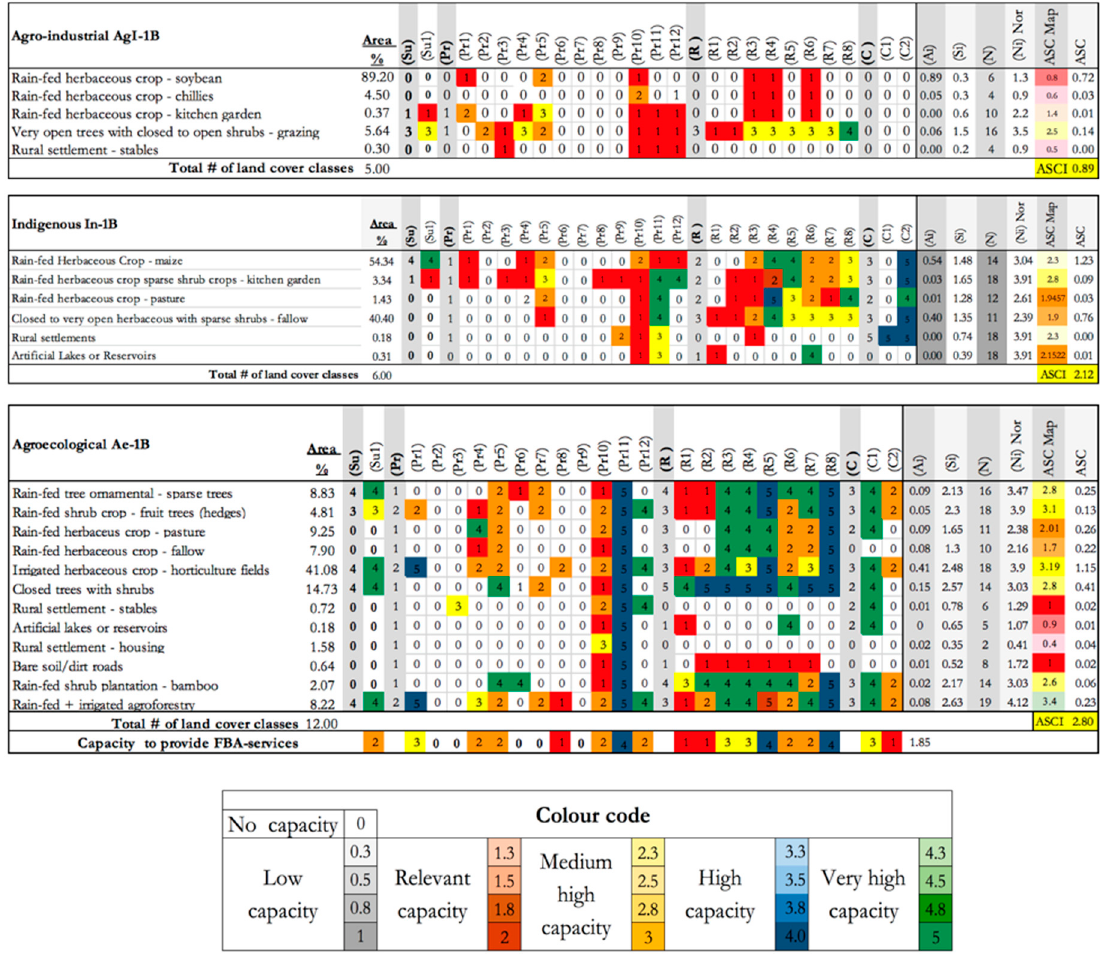
Figure 6. Agroecosystem service matrix of three farm-based agroecosystems in Bolivia (modified from [26]).